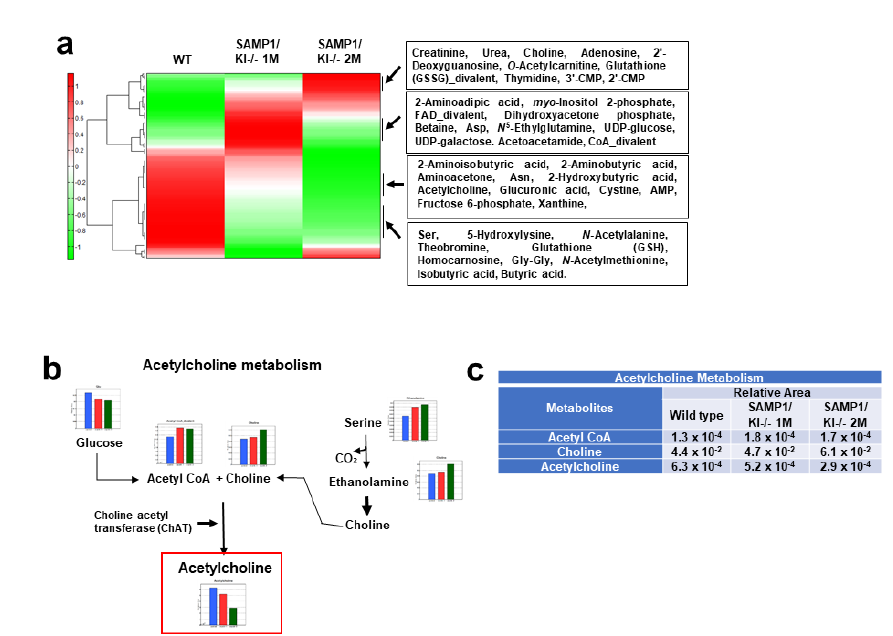
Figure 1. A comparison of the metabolic profile of mouse salivary gland tissues (SAMP1/kl +/+, 1-month-old SAMP1/kl -/-, and 2-month-old SAMP1/kl -/-) was conducted by capillary electrophoresis time-of-flight mass spectrometry (CE-TOFMS). ( a ) Hierarchical cluster analysis (HCA) and heatmap visualization of metabolic profiles. The horizontal axis and vertical axis show the sample names and peaks, respectively. HCA was performed for the peaks. The distance between peaks is displayed in tree diagrams. ( b ) The level of metabolites of acetylcholine metabolism was plotted on the pathway maps. The relative quantities of detected metabolites are represented as bar graphs (from left to right: SAMP1/kl +/+ (blue), 1-month-old SAMP1/kl -/- (red), and 2-month-old SAMP1/kl -/- (green) salivary glands). The red block highlighted the Acetylcholine concentration. ( c ) Comparisons of the relative amount of acetylcholine metabolites between SAMP1/kl +/+ salivary glands and SAMP1/kl -/- salivary glands at 1 month and 2 months.